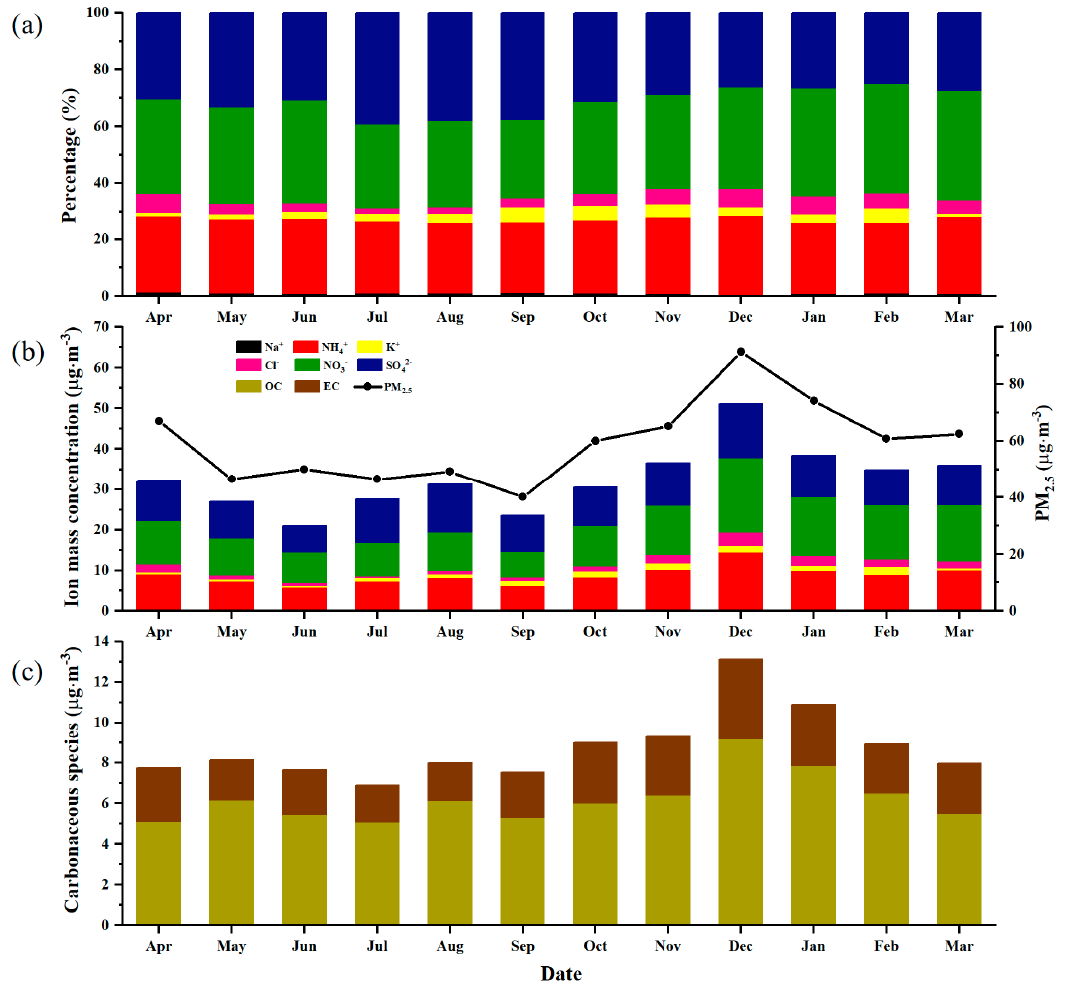
Figure 2. Monthly variation of ( a ) major water–solute inorganic ions (WSIIs) percentages, ( b ) their concentrations and ( c ) carbonaceous species.